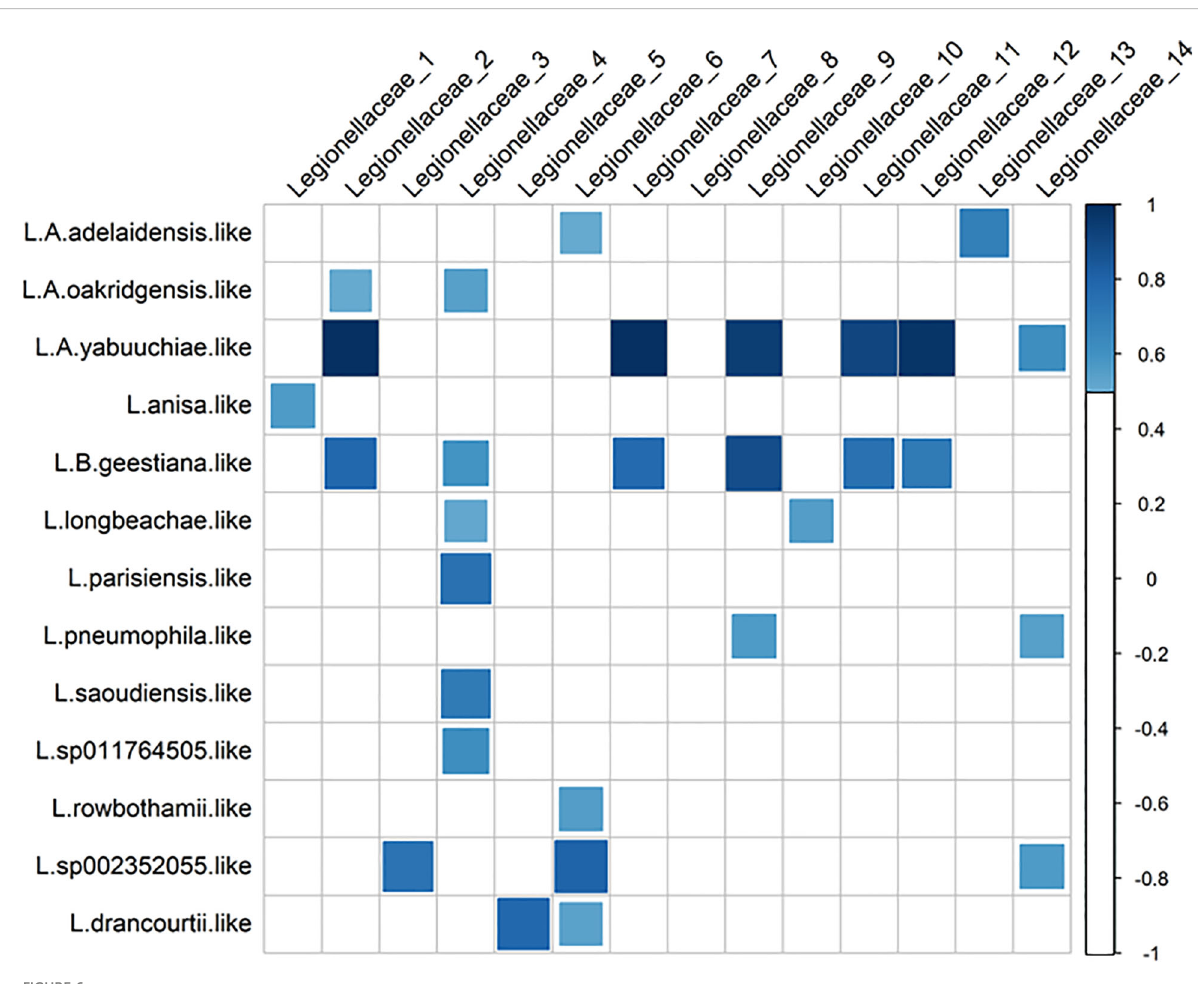
FIGURE 6 Correlations ( ≥ 0.5) between ASVs in the family Legionellaceae (Illumina) and species classi fi cation in the Legionella genus (Nanopore, bracken classi fi